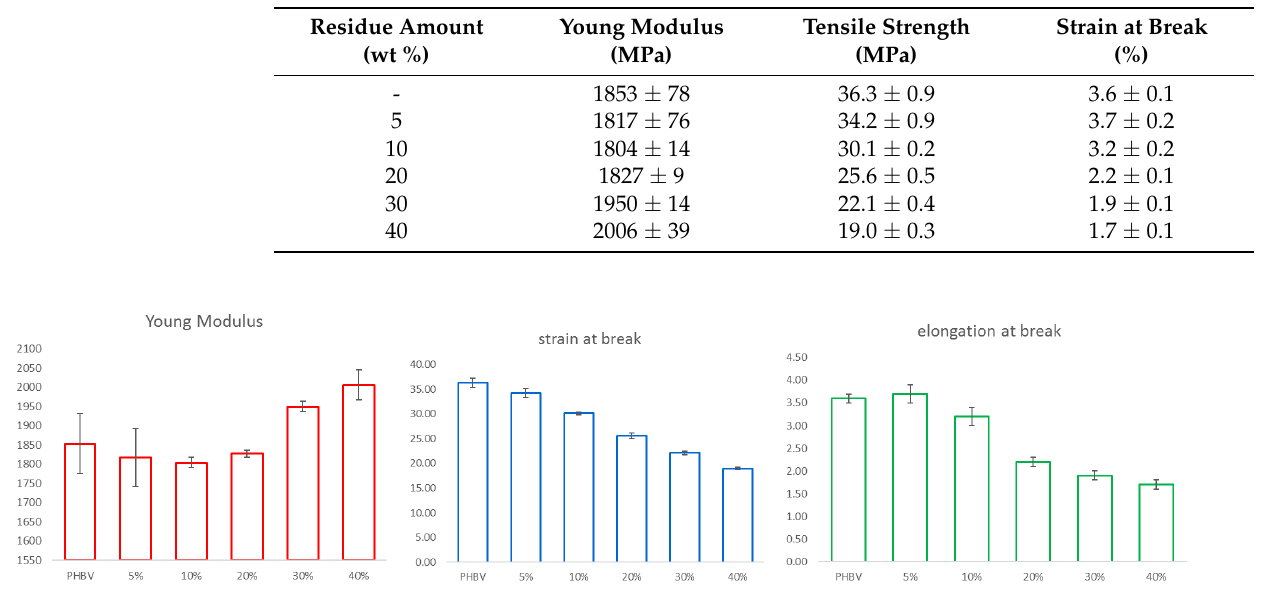
Figure 14. Tensile tests for composites prepared at 180 °C.